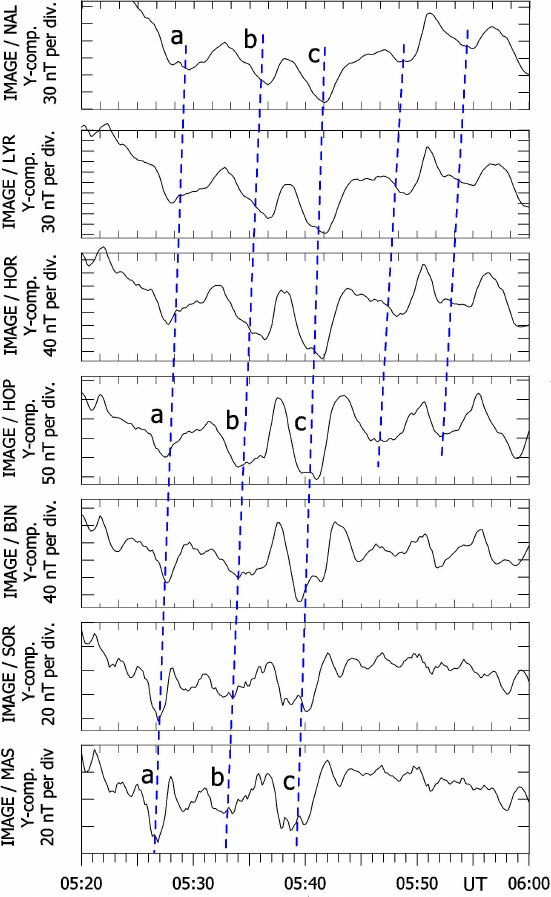
Fig. 9. Same format as in Fig. 3, concerning the Y component mag- netograms for the event of day 341, 1994. The dispersive character for the decreases marked as (a), (b) and (c), is apparent for all the stations in a latitude range extended from NAL to